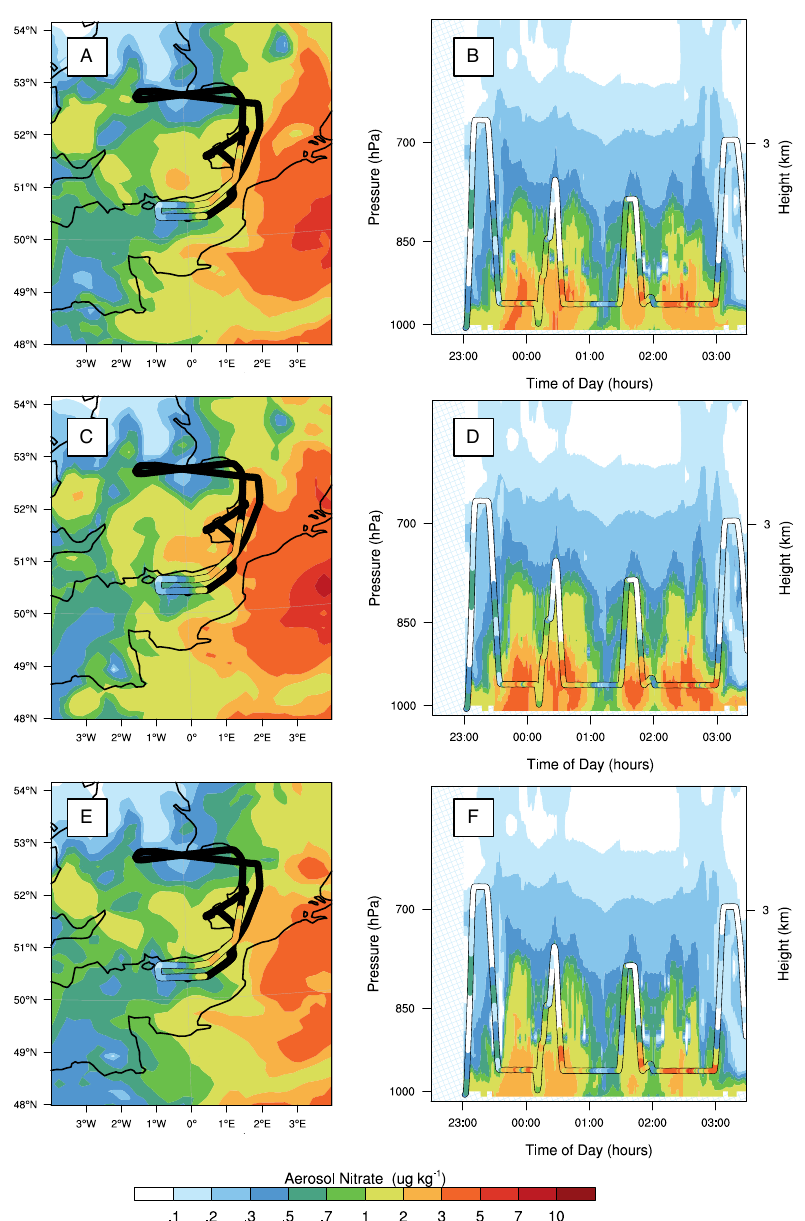
Figure 12. PM 10 nitrate mass loadings for the “het on” ( a and b ), “no Cl pathway” ( c and d ) and “het off” ( e and f ) for the B541 flight across the model domain. The aircraft flight track is indicated in all plots with a thick black line. Measurement data are superimposed upon that line using the same colour scale as the model data. ( a ), ( c ), and ( e ) are horizontal slices on the 960hPa pressure level at 01:00UTC (incorporating measurement data between 00:30 and 01:30UTC and 940 and 980hPa). ( b ), ( d ), and ( f ) are vertical curtain plots along the flight